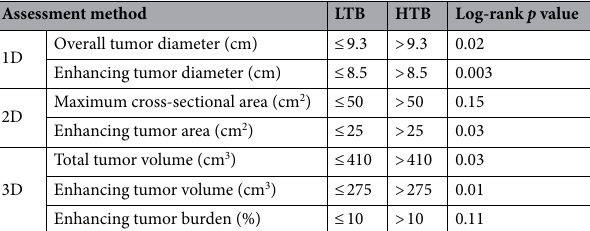
Table 3. Methods of patient assignment to LTB and HTB in each tumor assessment method. LTB: low tumor burden, HTB: high tumor burden, 1D: 1-dimensional, 2D: 2-dimensional, 3D: 3-dimensional.